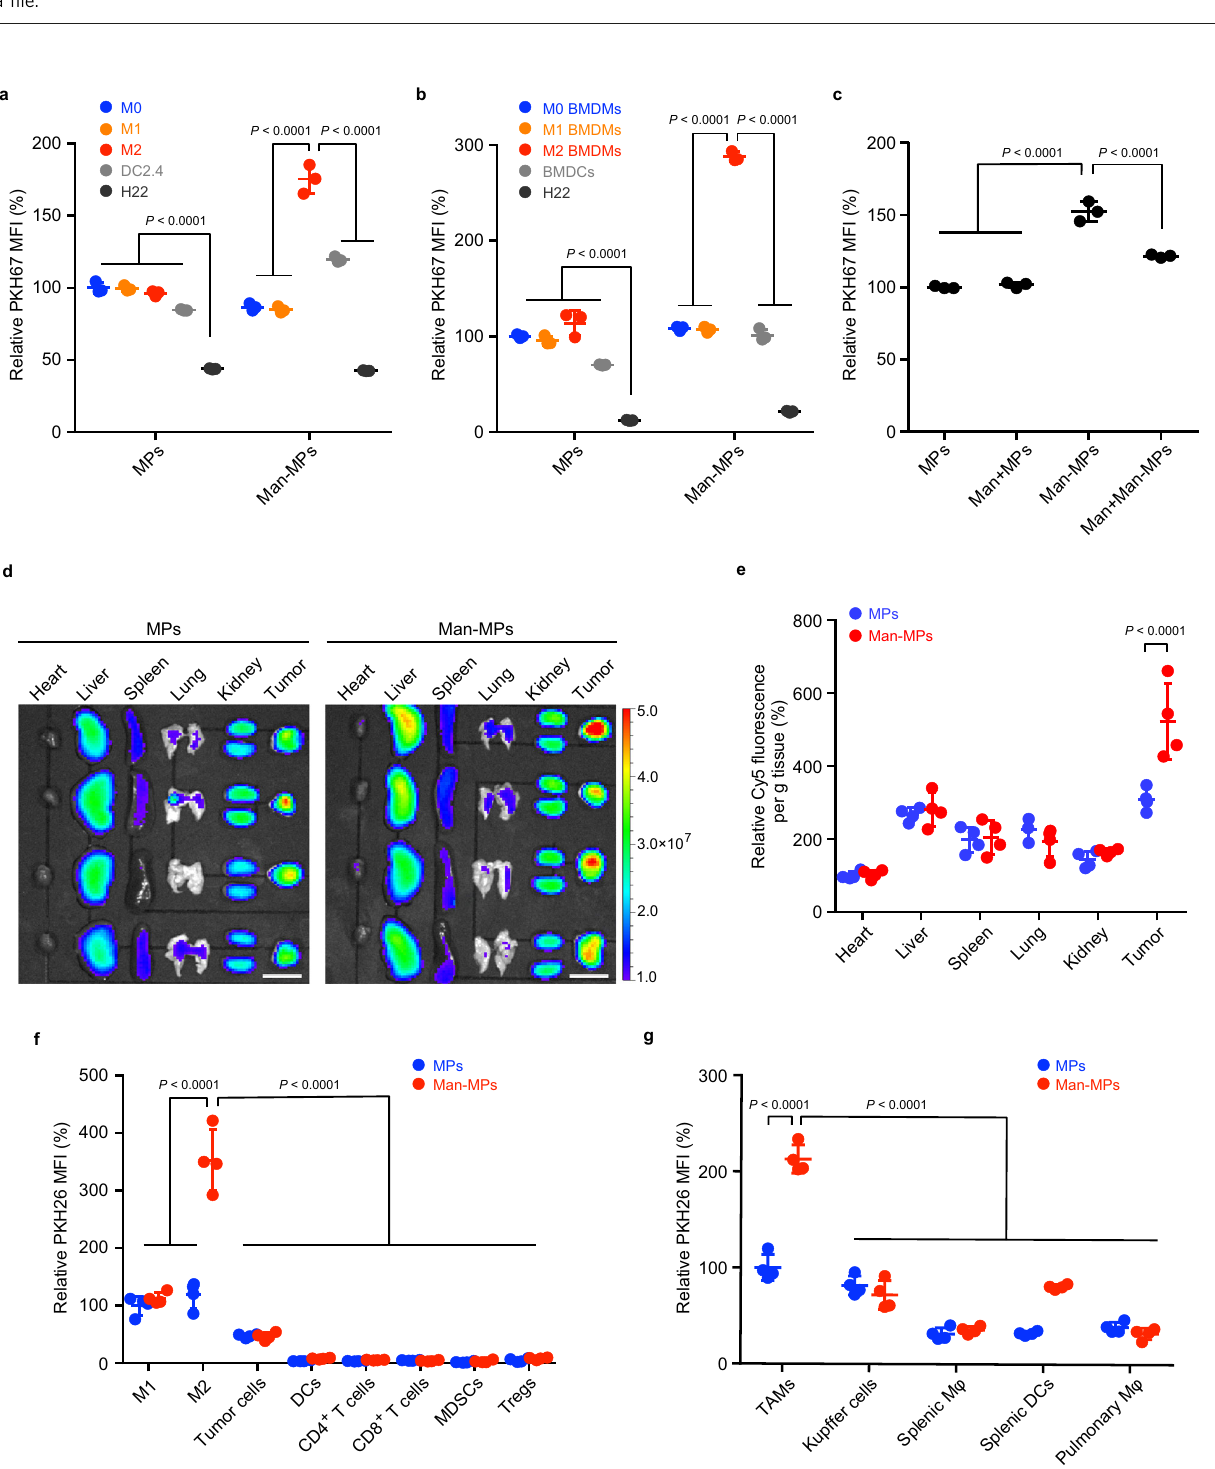
Fig. 1 Characterization of Met@Man-MPs. a Schematic of Met@Man-MPs as an ef fi cient drug to boost anti-PD-1 therapy. Met@Man-MPs with MMP activity ef fi ciently target to M2-like TAMs and degrade tumor collagen. (1) Met@Man-MPs repolarize M2-like TAMs to M1-like phenotype, resulting in the recruitment of CD8 + T cells into tumor tissues and the ameliorated tumor immunosuppressive microenvironment. (2) Collagen-degrading capacity of Man-MPs contributes to the in fi ltration of CD8 + T cells into tumor interiors and enhances tumor accumulation and penetration of anti-PD-1 antibody. (3) Met@Man-MPs synergistically inhibit tumor growth in combination with anti-PD-1 antibody, generating long-term memory immunity. b Hydrodynamic diameters of MPs and Man-MPs with or without Met by DLS analysis. Polydispersity index values are indicated in the brackets. c Zeta potentials of MPs and Man-MPs with or without Met by DLS analysis. Data are presented as means ± s.d. ( n = 3 independent samples). d Morphology of MPs and Man-MPs with or without Met by TEM. Images are representative of three independent experiments. Scale bars: 500 nm. e Drug release of Met@MPs and Met@Man-MPs in PBS at different pH values. Data are presented as means ± s.d. ( n = 3 independent samples). Source data are provided as a Source Data fi le.